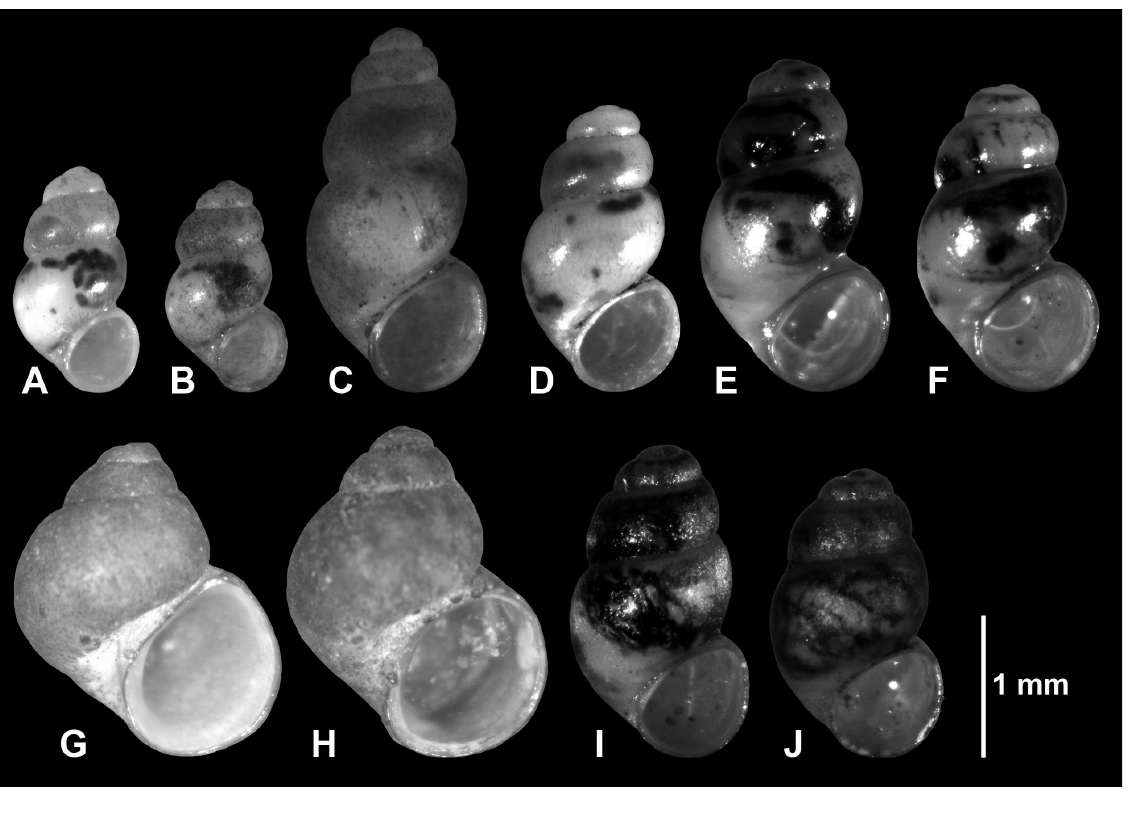
Fig. 4. Types. A – B . Catapyrgus jami sp. nov. C – D . Opacuincola lisannea sp. nov. (D from